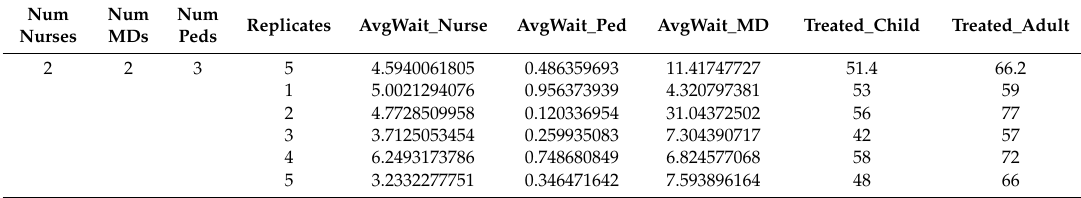
Figure 5. Simulation model when eight adult patients arrive per hour. Table 1. Average statistics for each response within each experimental run.